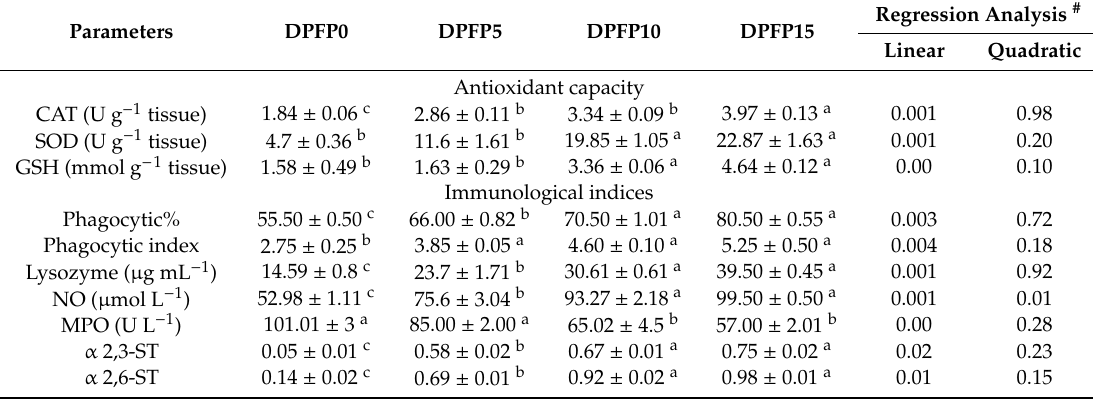
Table 5. The e ff ects of dietary doum palm fruit powder (DPF) on the hepatic antioxidant capacity and immunological indices of African